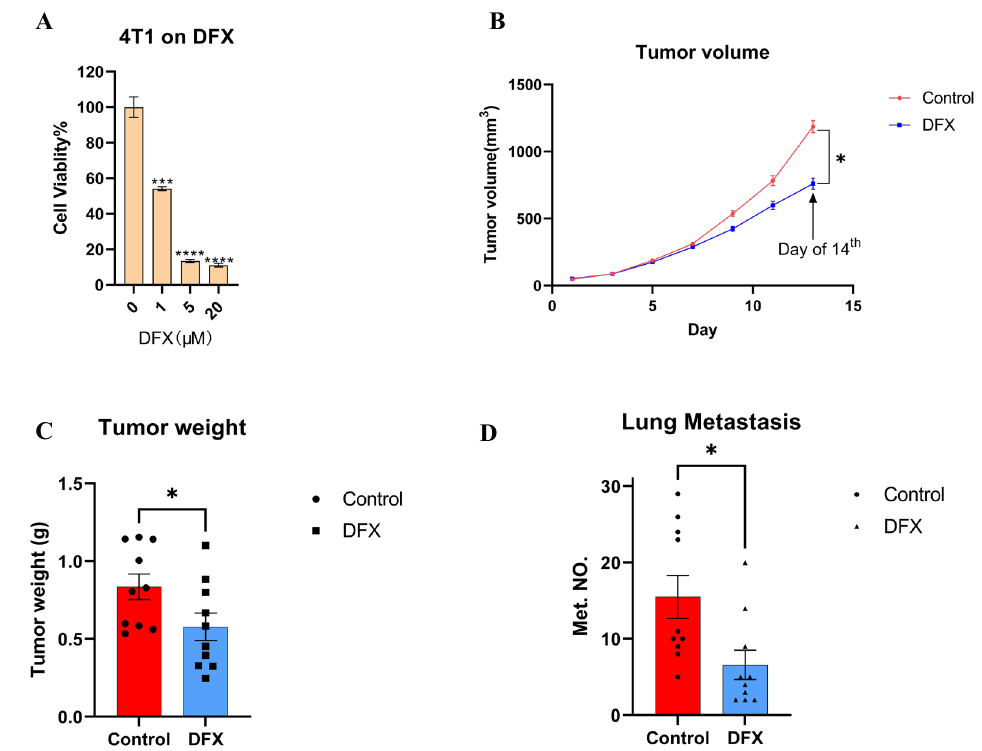
Figure 1. DFX inhibits the growth of 4T1 primary and lung metastatic tumor. ( A ) Murine TNBC cells 4T1 were treated for 48 h with iron chelator DFX with different concentrations ( n = 6). Cell viability was determined via Cell Proliferation Kit II (XTT). Cell viability in the absence of treatment was set at 100%. Treatment groups were compared with Control group, respectively. The Student’s t test with Welch’s correction was utilized to compare two groups, *** p < 0.001, **** p < 0.0001 and Data shown as the mean ± S. E. M. ( B ) 4T1 cells (1 × 10 5 ) were injected in left mammary gland of BALB/c female mice (6–8 weeks old). After 7 days, mice were randomly divided into two groups ( n = 10), and treatment was initiated as indicated. DFX and Ctrl treated groups were treated with of 4T1. At the day of 14th, the tumor volumes were abstracted, and the Student’s t test was utilized to compare two groups, * p < 0.05 ( C ) Tumor weight was measured in the end of study. DFX effectively decreased tumor weight. The Student’s t test was utilized to compare two groups, * p < 0.05 ( D ) Lung tissue were collected, and metastatic tumor numbers were counted under stereomicroscope. DFX effectively decreased the number of 4T1 lung metastasis. The Student’s t test was utilized to compare two groups, * p <